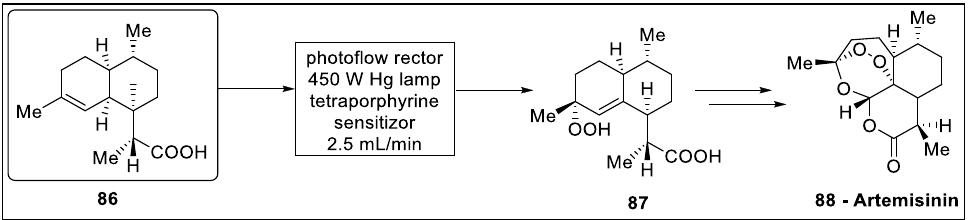
Molecules 2022 , 27 , x FOR PEER REVIEW 21 of 31 Scheme 25. Synthesis of myriceric acid A intermediate: 84 — heptamethyl-3,16-dioxooctadecahydro- (epoxymethano)picen-13-yl nitrite, 85 — myriceric acid A intermediate. In a follow-up paper [96], the use of 1.7 W UV-LED (365 nm) was also investigated, and an automated photo-microreactor system employing an array of 48 LEDs yielded 5.3 g (70%; productivity: 132 mg/h) of the product in 40 h under the identical conditions-flow rate of 1 mL/min (residence time 12 min) [79]. 3.9. Artemisinin Artemisinin and its derivatives are among the most important drugs against malaria, which is caused by parasitic Plasmodium infection. Clinical practice shows that, unlike other antimalarials, artemisinin is active during all the life-cycle stages of the parasite [97]. Whereas these drugs are almost nontoxic to normal cells, several studies have confirmed their potent antitumor activity [98]. The total synthesis of artemisinin is too laborious to supply the highly cost-sensitive market. Seeberger and Lévesque [99] reported an innovative and practical synthesis (Scheme 26) under a continuous-flow process from dihydroartemisinic acid, 86 [100]. The continuous-flow system was fabricated in-house with FEP tubing wrapped around a Schenk photochemical reactor containing a 450 W medium-pressure mercury lamp that was cooled to 25 °C. At first, tetraporphyrine (TPP)-sensitized flow photooxidation (flow 2.5 mL/min) of dihydroartemisinic acid ( 86 ) produced the hydroperoxide 87 in 75% yield and at the rate of 1.5 mmol/min. The photooxidation step was followed by acid-catalyzed Hock cleavage and triplet-oxygen oxidation (continuous-flow under the same